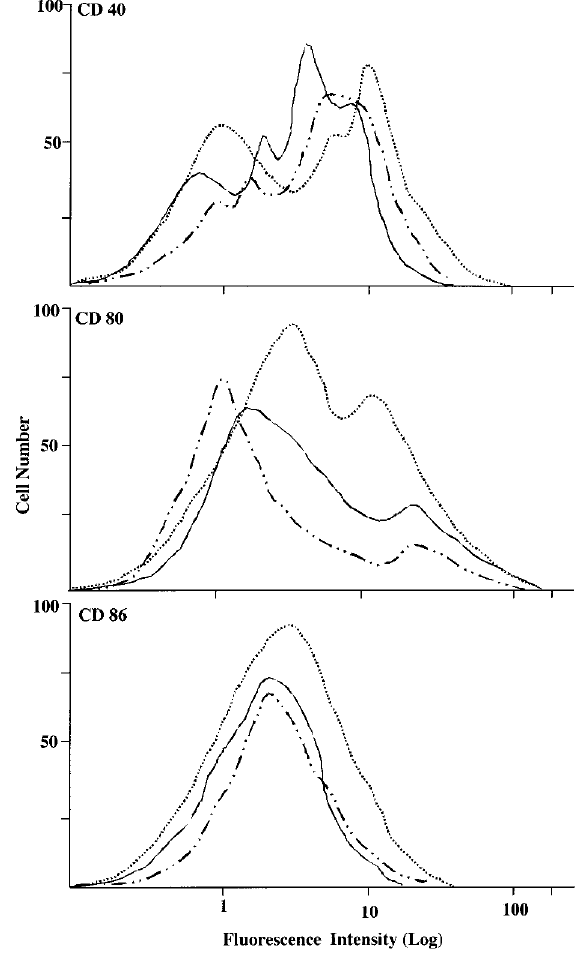
FIG. 4. Influence of RXM on co-stimulatory molecule expres- sions induced by antigenic stimulation in vitro . BALB/c mice were immunized by intraperitoneal injection with 8.0 m g/ml of hemocyanin absorbed to 4.0mg of aluminum hydroxide in a volume of 0.5ml. Spleen cells prepared mice 10 days after immunization were cultured with 5.0 m g/ml of RXM and 100.0 m g/ml of hemocyanin for 24h. The expression was analyzed by flow cytometer: (____ ) cultured without antigen, (. . . . .) cultured with antigen, (_ . . _ . . _ ) cultured with antigen and